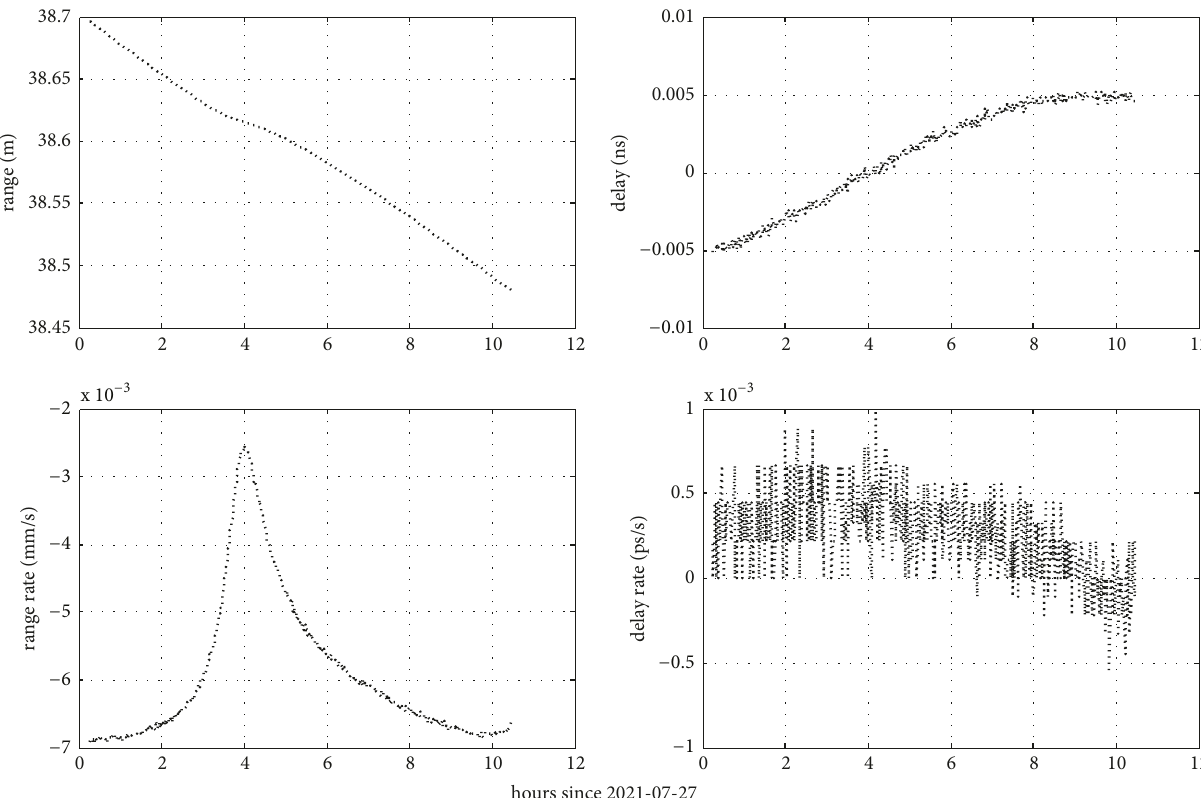
Figure 2: Measurement differences using DE421 and DE430.